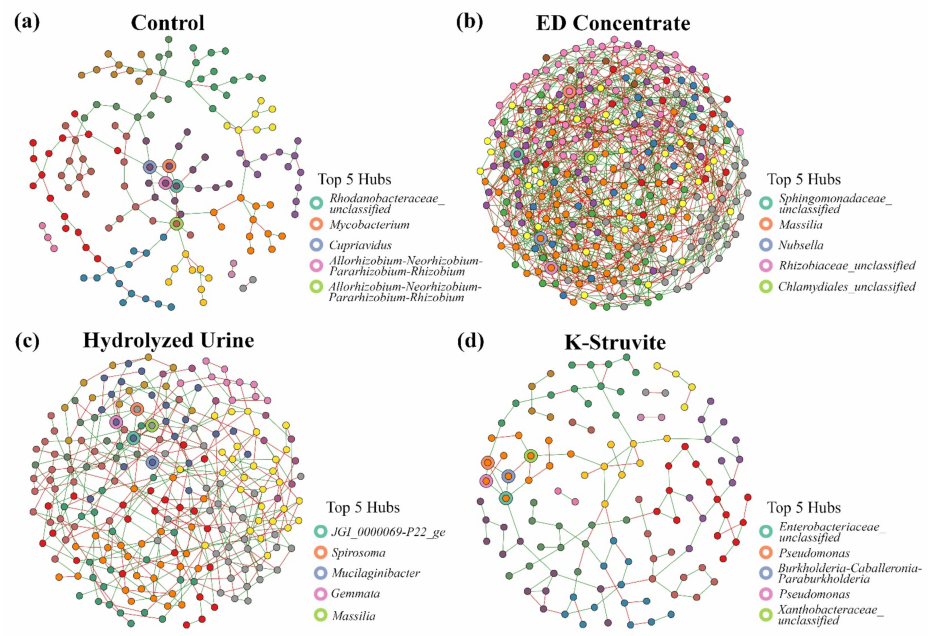
Figure 4. Lettuce root-associated bacterial community networks grouped per urine-derived fertilizer treatment: ( a ) NPK control network with 141 nodes, 149 edges (102 positives and 47 negatives), and 15 clusters with a 0.82 modularity (i.e., a measure for how good the division in clusters is); ( b ) Electro- dialysis (ED) concentrate network with 311 nodes, 964 edges (539 positives and 425 negatives), and 9 clusters (modularity = 0.45); ( c ) Hydrolyzed urine network with 222 nodes, 413 edges (228 positives and 185 negatives), and 11 clusters (modularity = 0.60); ( d ) K-struvite network with 120 nodes, 130 edges (92 positives and 38 negatives), and 15 clusters (modularity = 0.79). Nodes are colored by cluster (clusters were determined using the fast greedy modularity optimization algorithm). The top 5 hub nodes are indicated by the colored borders (hubs were determined using Kleinberg’s hub centrality scores). The green and red edges indicate a positive or negative correlation between the network nodes,